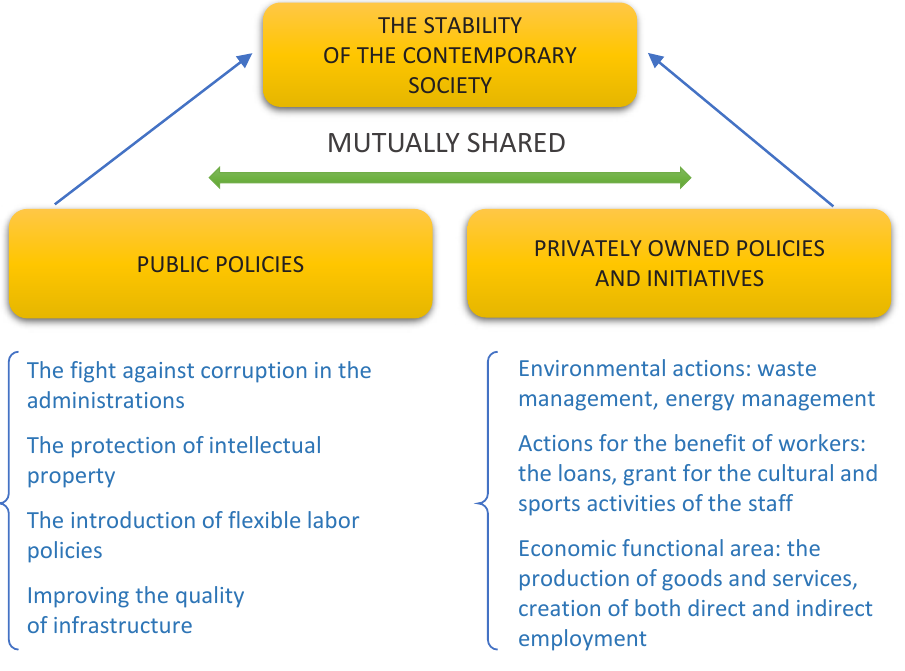
Figure 3. Personal elaboration according to the foundations of El Malki (2010), World Bank (2005) and Navas and Guerras